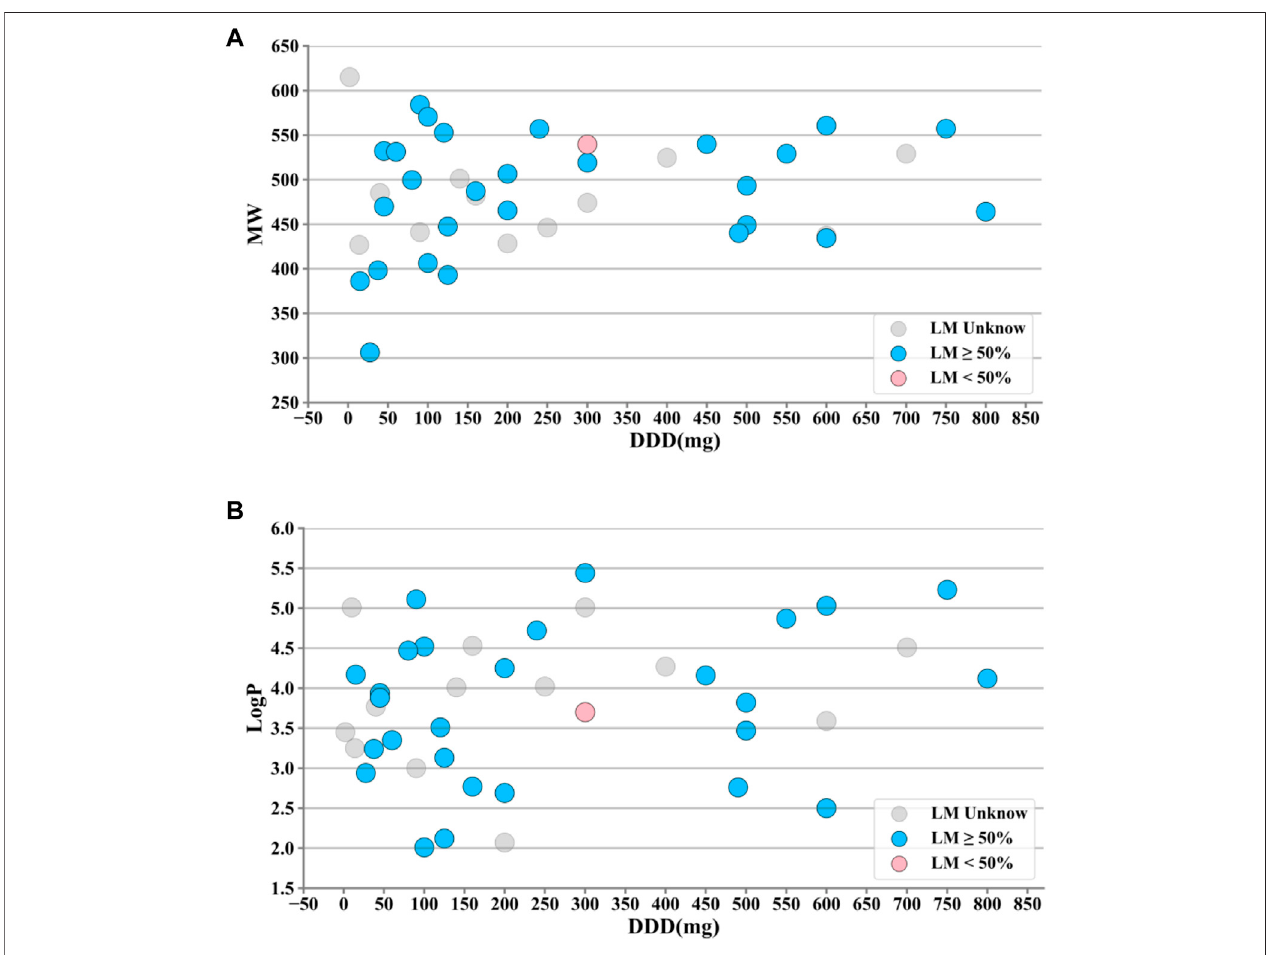
FIGURE 2 | Property distributions of 44 kinase inhibitors (KIs). (A) Distributions of de fi ned daily dose (DDD) and molecular weight (MW) values along with liver metabolism(LM)markups. (B) DistributionsofDDDandoctanol – waterpartitioncoef fi cient(LogP)valuesalongwithLMmarkups.ItwasobservedthatthemajorityofKIs metthecriteriaofLogP ≥ 3,DDD ≥ 100mg,and400 ≤ MW < 600.Additionally,themajorityofKIs(29outof44)haveaknowndegreeoflivermetabolism(LM)greaterthan 50%, while only one KI has a known degree of liver metabolism (LM) less than 50%. #A few outliers with large deviations were